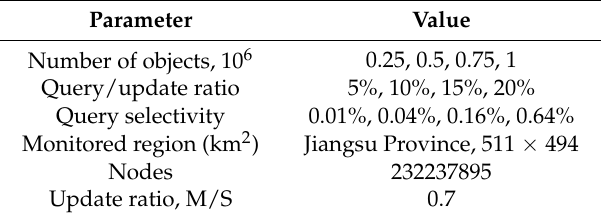
Table 3. Workload configuration for range spatial join